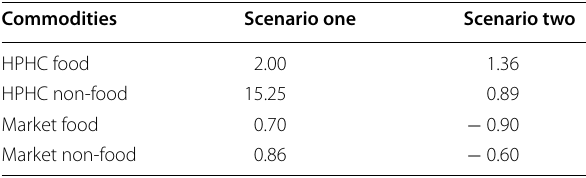
Table 5 Simulated changes (percentage) in domestic price